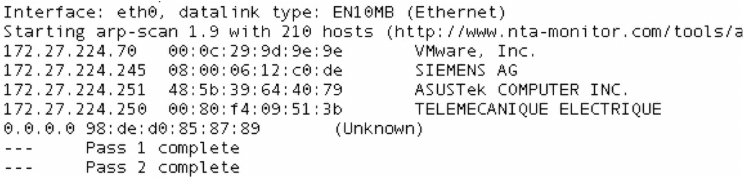
Figure 15. ARP scan results.